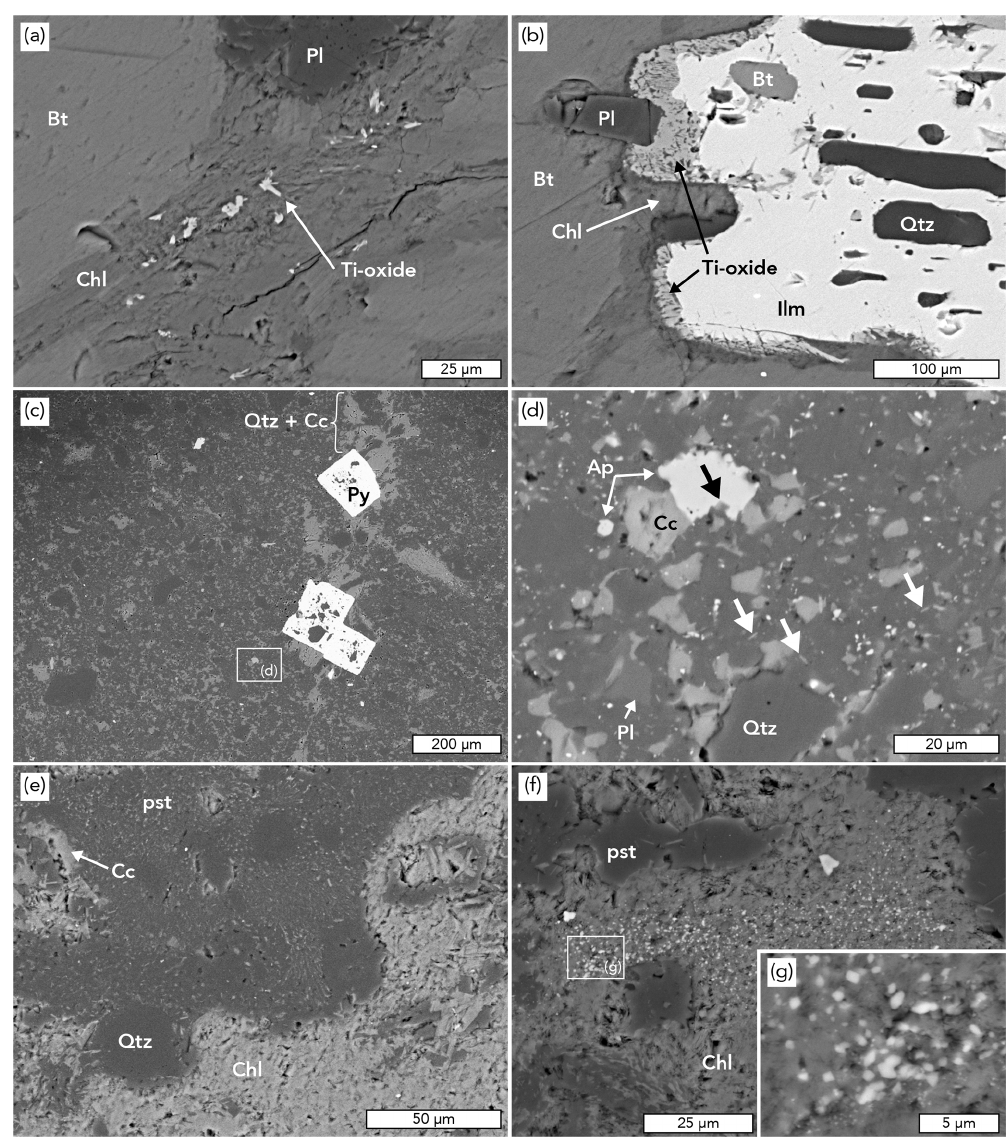
Figure 5. Back-scattered electron images of selected microscopic observations. Mineral abbreviations after Whitney and Evans (2010) (a) Breakdown of biotite to chlorite + Ti-oxide + unidentified K-phase. (b) Reaction rim around ilmenite inclusion in bi- otite: ilmenite + biotite = Ti-oxide + chlorite + unidentified K-phase. (c) Pseudotachylyte with vertical, crosscutting vein with cal- cite + quartz + pyrite. (d) Microstructure of pseudotachylyte. Calcite (light gray); unknown needle-shaped (white arrows) microcrystallites; and bright, submicrometer-sized oxide/sulfide droplets are dispersed in the cryptocrystalline or amorphous matrix. Note the embayed edges (black arrow) of an apatite survivor clast versus a much smaller, euhedral apatite crystal further left. (e) Meandering alteration front be- tween chloritized and pristine pseudotachylyte. No preferred orientation of chlorite. Note, in contrast, the fan-like growth of microcrystallites in the matrix. (f–g) Micrometer-sized crystals of Ti-oxide (determined by EDS) finely dispersed in chlorite which replaced cryptocrys- talline/amorphous pseudotachylyte